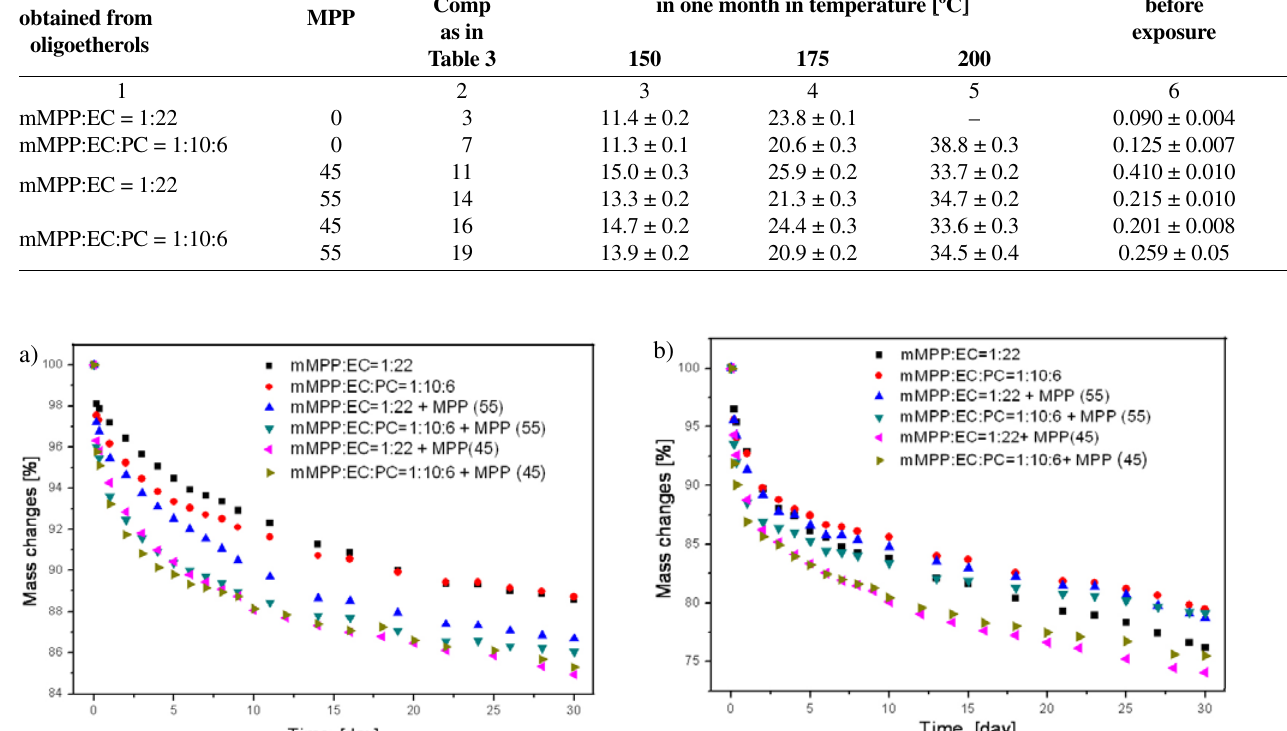
Table 5. Thermal stability,compressive strength anfd flame properties of foam (continued) No Mass loss in% wt. after exposure Foams in one month in temperature [[ o C ]] before obtained